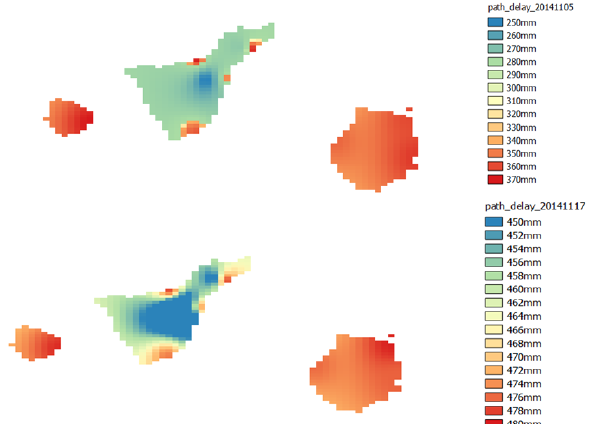
Figure 3. Master and slave tropospheric path delays from AEMET interpolated station data